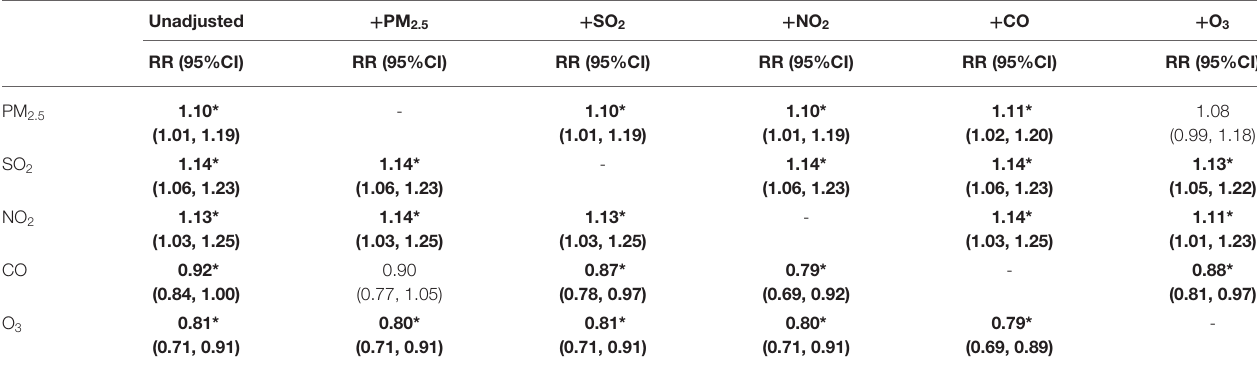
TABLE 8 | The relative risk (RR) of hospital admission for asthma in children per interquartile range (IQR) increase in different air pollutants in different strongest single lag days: two-pollutant model. Unadjusted + PM 2.5 + SO 2 + NO 2 + CO + O